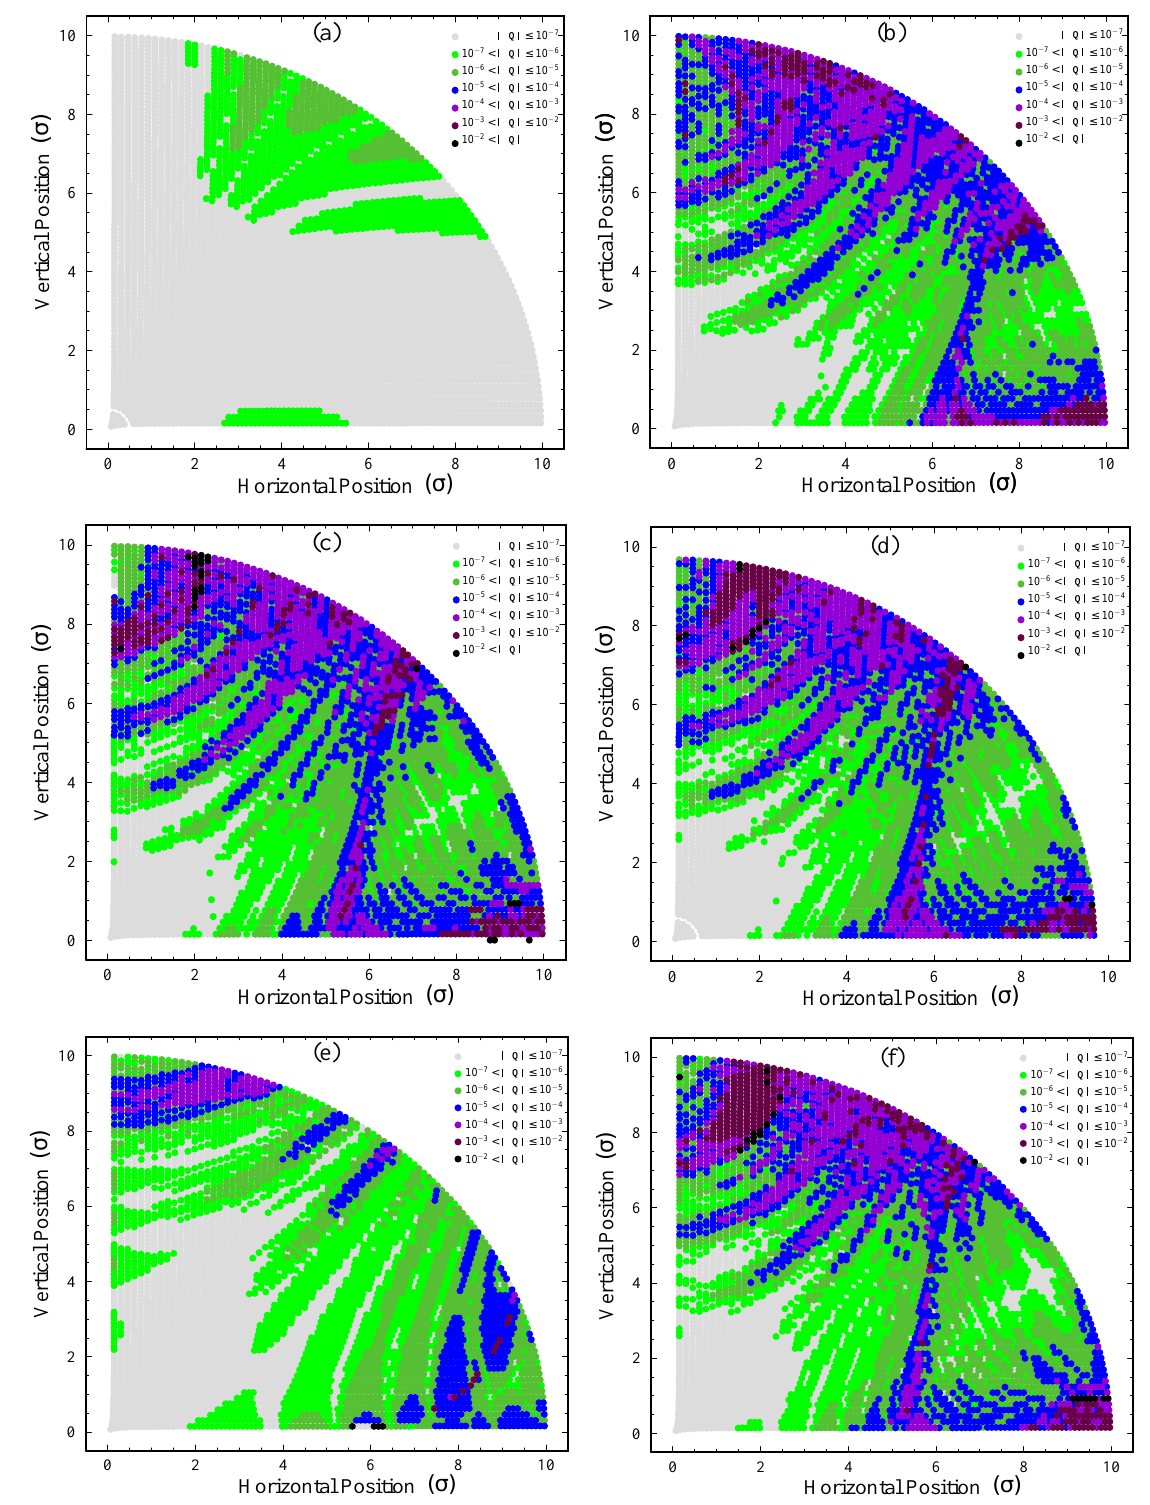
FIG. 2. (Color) Diffusion maps representing the change of the betatron tunes with time as a function of horizontal and vertical starting amplitude. The tune change was inferred by tracking single particles over 2 3 500 turns and subsequent frequency analysis. The color assignment is logarithmically scaled with the tune change j D Q j over 500 turns. (a) Head-on collisions only, (b) head-on and long-range collisions, (c) head-on plus long-range collisions and FNAL triplet errors (one random seed), (d) head-on plus long-range collisions and KEK triplet errors (one random seed), (e) KEK triplet errors only (one random seed), and (f) long-range collisions and KEK triplet errors (one random seed), but no head-on